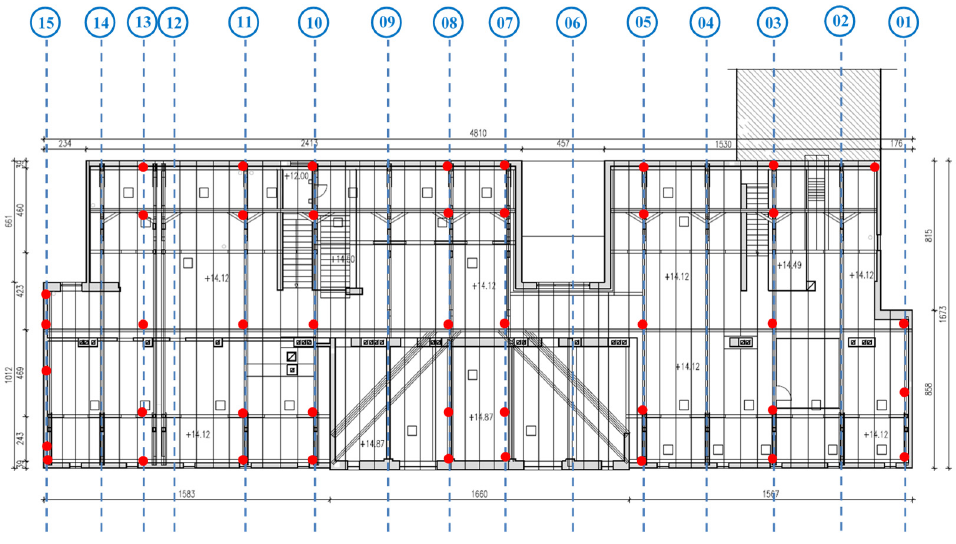
Figure 16. Positions for moisture content and dynamic MOE measurements positions.